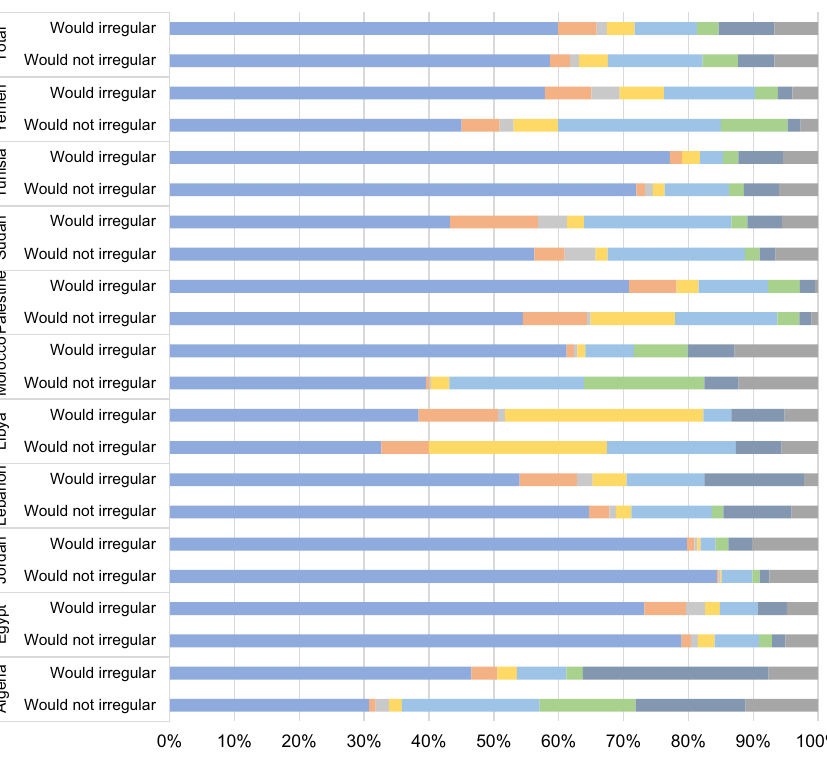
Fig. 3 Stated reasons for wanting to emigrate by country and irregularity willingness. Notes: Weighted. Stacked graphs, actual figures over 100 due to multiple answers. “Total” figure country-level average. Kuwait not shown due to low propensity to emigrate, no data for